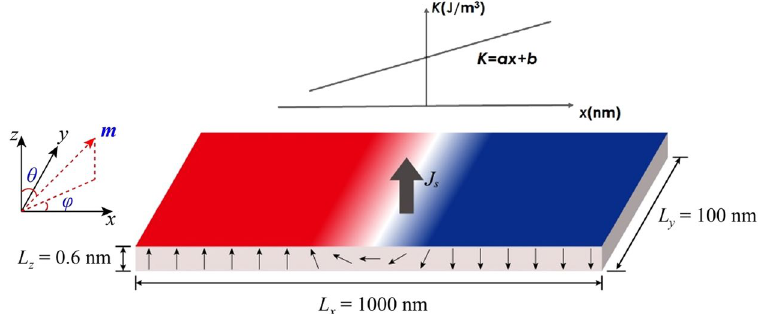
Figure 1. Schematic of SOT-driven domain wall in a nanotrack with magnetic anisotropy gradient. (The theoretic analysis in the paper is based on the up-down domain wall structure in the coordinate system shown in Fig.